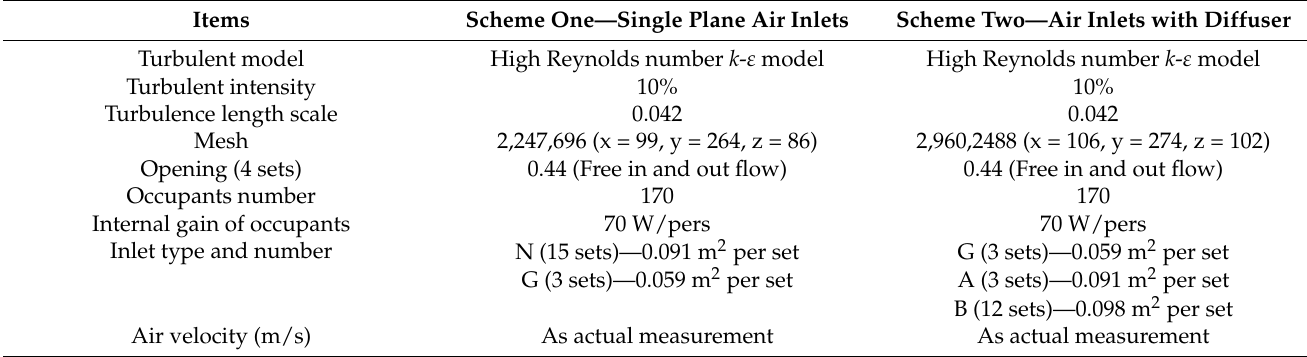
Table 2. The boundary conditions of each scheme.